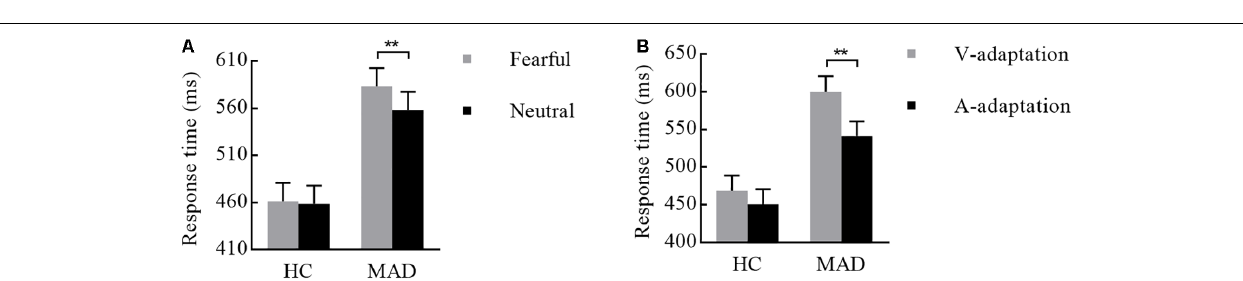
FIGURE 5 | Sampled stimuli and procedure in Experiment 3. The procedure of Experiment 3 showed the sequence of events within a trial for visual-adaptation mode (V-adaptation, A ) or auditory-adaptation mode (A-adaptation, B ).